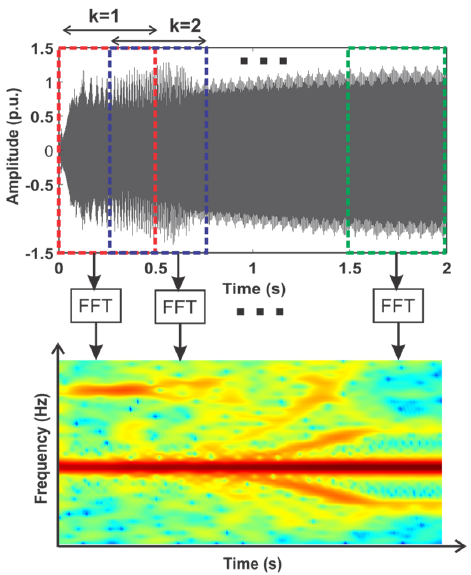
Figure 4. Short-time Fourier transform with overlap of a time domain signal.